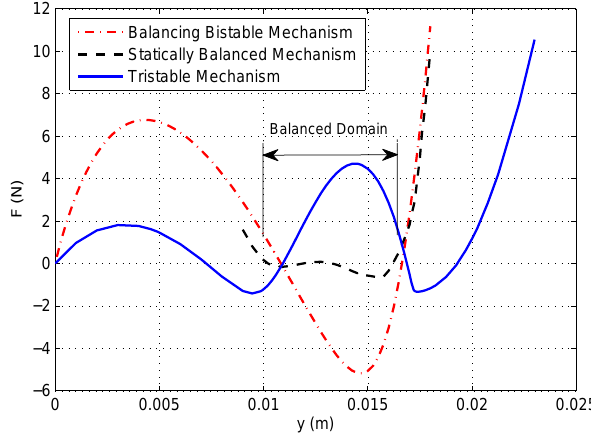
Figure 7. Force-displacement characteristics of the optimized bal- ancing bistable